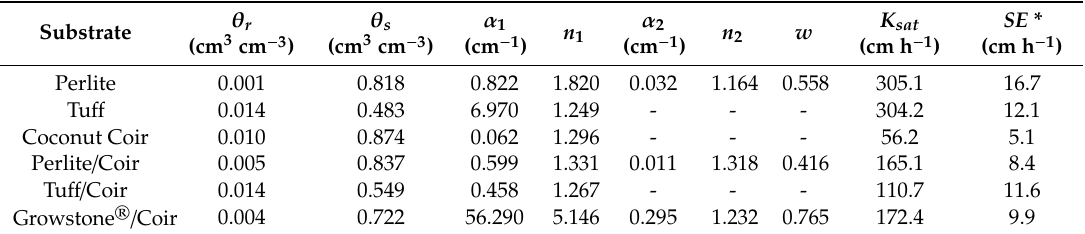
Table 3. Substrate WC parameters and measured K sat (for parameter definitions see Equations (6) and (7) in Section 2.3).